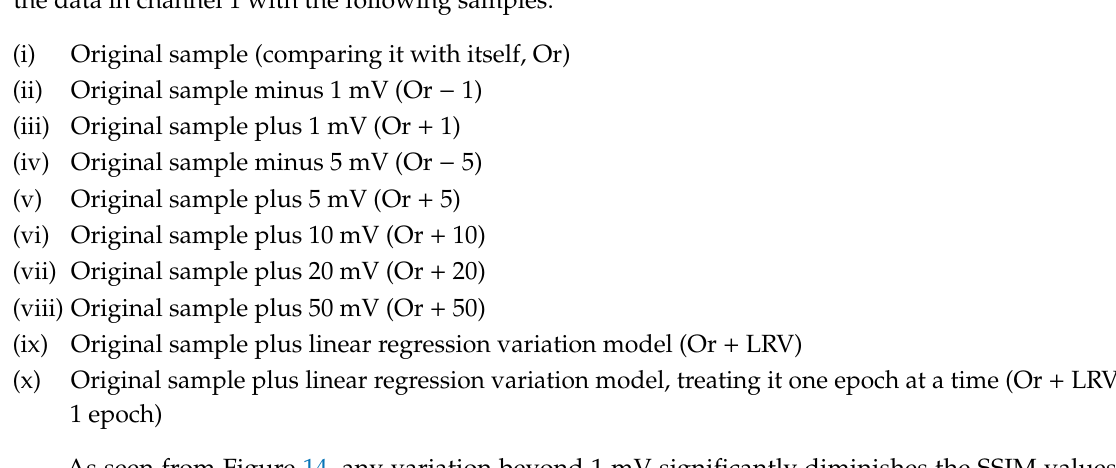
Figure 13. Model of the variation generated by numerical methods. Figure 14. The effect of variation on SSIM.